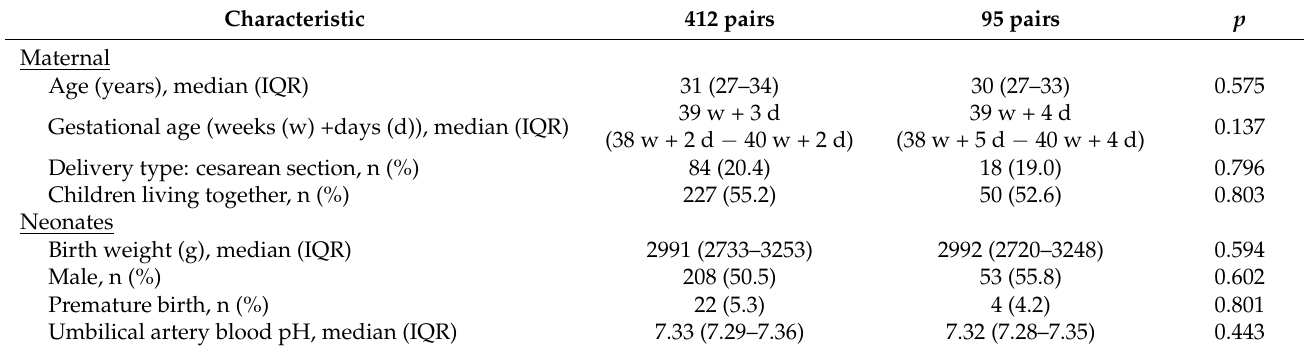
Table 1. Participant